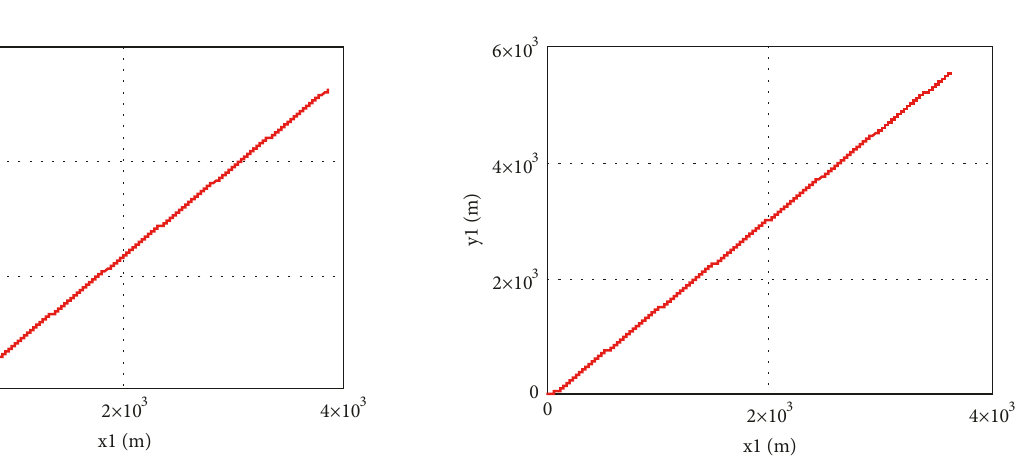
Figure 10: Vessel trajectory during accelerated rotation at a given heading angle of 57.3 degrees for values 𝑧 ∗ 3 = 0.05𝑟𝑎𝑑 ⋅ 𝑠 −1 , 𝑧 ∗ 6 = 1𝑟𝑎𝑑 .